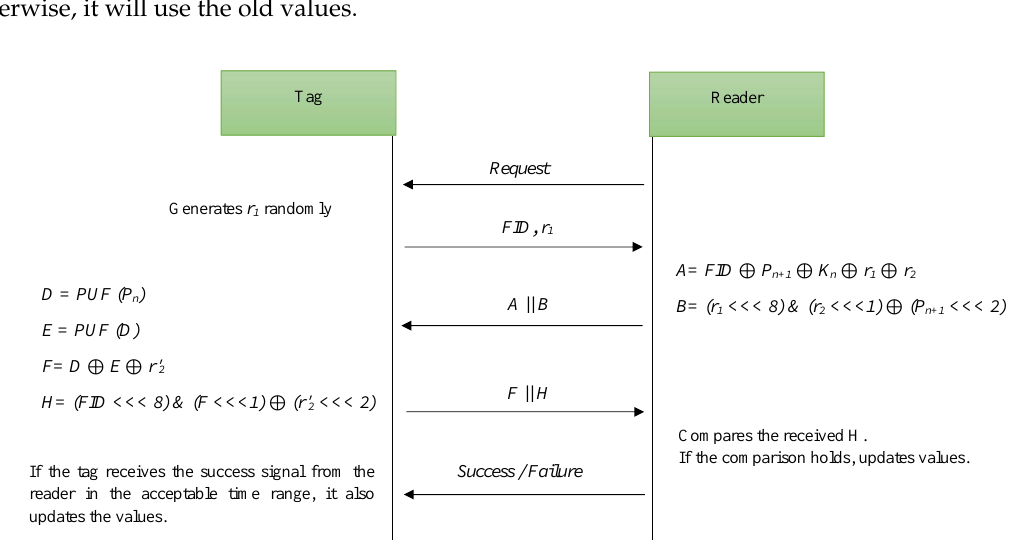
Figure 2. Time sequence diagram of Xu et al.’s protocol for single tag